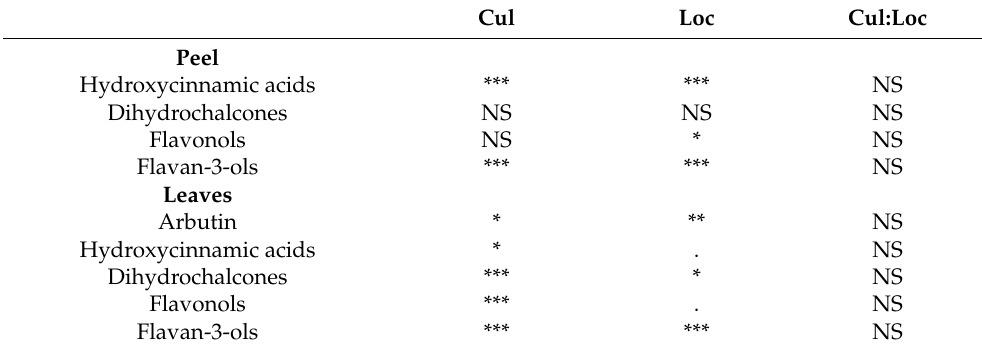
Figure 6. Phenolic content in apple flesh presented in four groups: Hydroxycinnamic acids, dihy- drochalcones, flavonols, and flavan-3-ols (mg kg − 1 FW; mean ± SE) for cultivars ‘Golden Delicious’ and ‘Majda’ at two different locations (L1 and L2) at harvest and following storage. The pattern is quite similar in apple peel, but the differences are not that extreme (Figure 7 and Table 2). Here, the highest difference is in the content of hydroxycinnamic acids. Compared to cv. ‘Golden Delicious’, cv. ‘Majda’ has about 13 times lower content of hydroxycinnamic acids (Table S8). Location 1 represents 67% content of hydroxycinnamic acids at L2. There were no statistical differences between cultivars in dihydrochalcone and flavonol content, but the latter did vary between locations. Again, flavan-3-ol content differed in cv. ‘Golden Delicious’ (four times higher content) in comparison to cv. ‘Majda’. Table 2. Two-factor ANOVA for cultivar (Cul: ‘Golden Delicious’ and ‘Majda’) and location (Loc: L1 and L2) and their interactions ( p < 0.05).